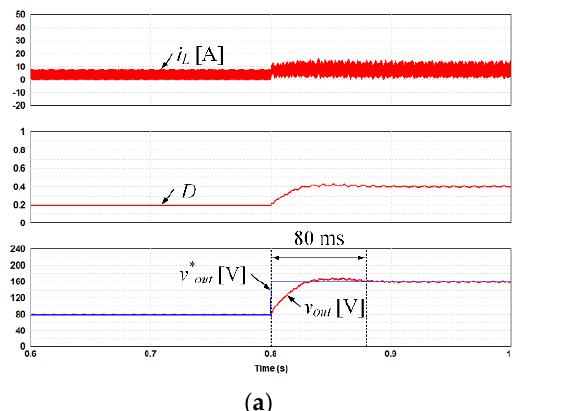
Figure 9. Simulation results of integrated OBC which performs battery charging: ( a ) voltage and ( b ) current of the single-phase grid source, ( c ) DC-link voltage and reference DC-link voltage, and ( d ) output voltage and reference output voltage.